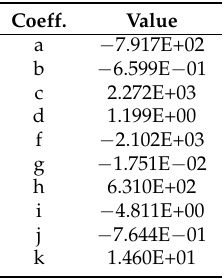
Table 4. V2V equation coefficients.